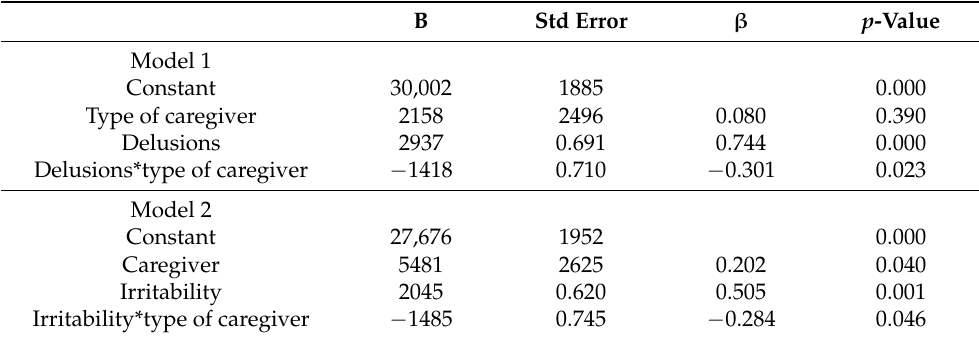
Table 4. Hierarchical regression analysis testing moderating effects of the type of caregiver on the association between neuropsychiatric symptoms and